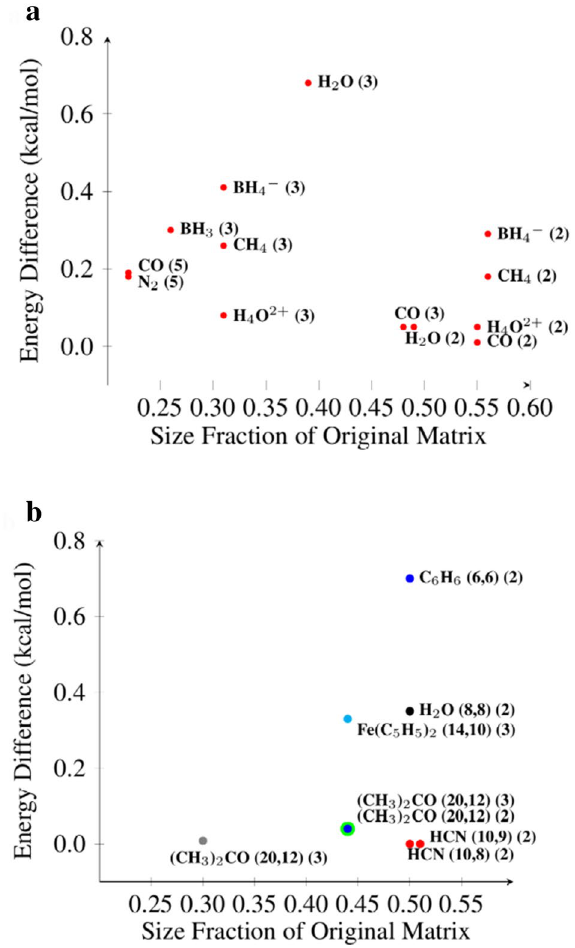
Figure 3. Comparison of energy difference and size reduction for different molecule clusters within chemical accuracy. ( a ) Molecule clusters using FCI and the sto-3g minimal basis set are shown. Those in the lower right corner from a k-clustering with k = 2 , shown as “(2)”, are the best results from an accuracy perspective. The others have smaller size and less accuracy. ( b ) Molecule clusters using CASSCF and different basis sets are shown. These are all from a 2- or 3-clustering . In this case the accuracy is independent of size. The basis set used for each molecule is noted by color: sto-3g is red, cc-PVQZ is blue, def2-svp is gray, def2-TZVP is cyan, cc-PVDZ is black, and 6-31G ⋆ is